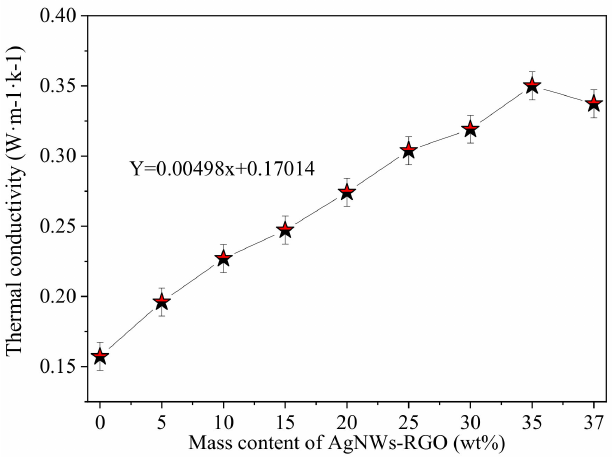
Figure 8. Thermal conductivity of composite films with different AgNWs-RGO mass